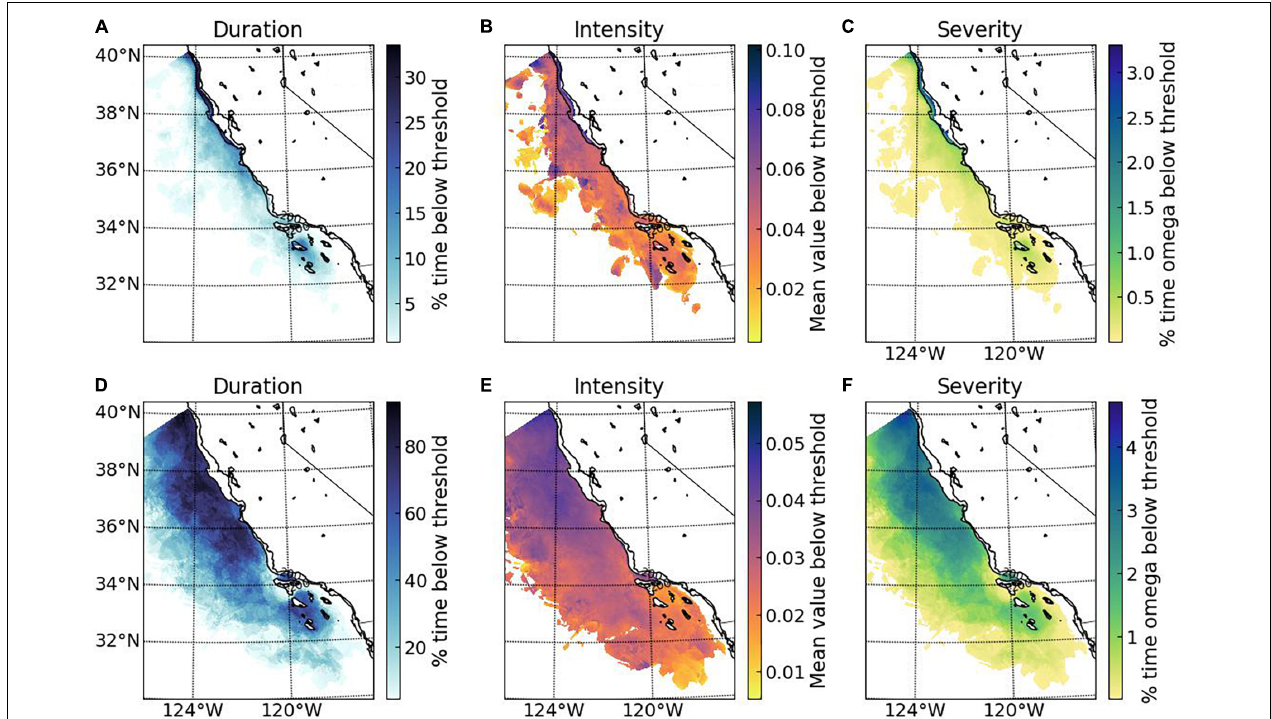
FIGURE 5 | Examples of threshold applications to modeled estimates of pH at 100 and 300 m along the California coast for juvenile and adult survival, respectively. Magnitude, duration, and severity of exposure were estimated for: upper (A–C) , juvenile decapod survival threshold (pH = 7.75; applied for 30 days over the period of March to July); and lower (D–F), adult decapod survival threshold (pH = 7.65; applied for 180 over the entire year; for details see section “Materials and